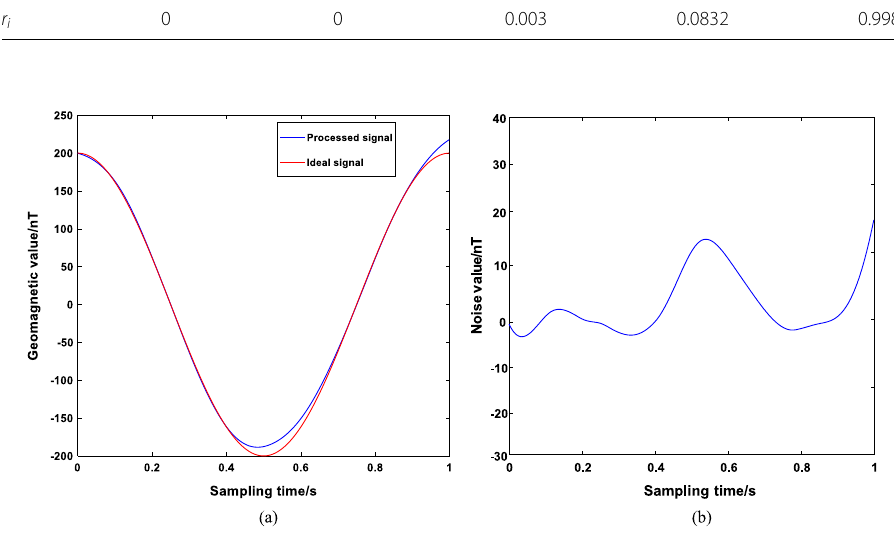
Fig. 9 Final processed signal and ideal